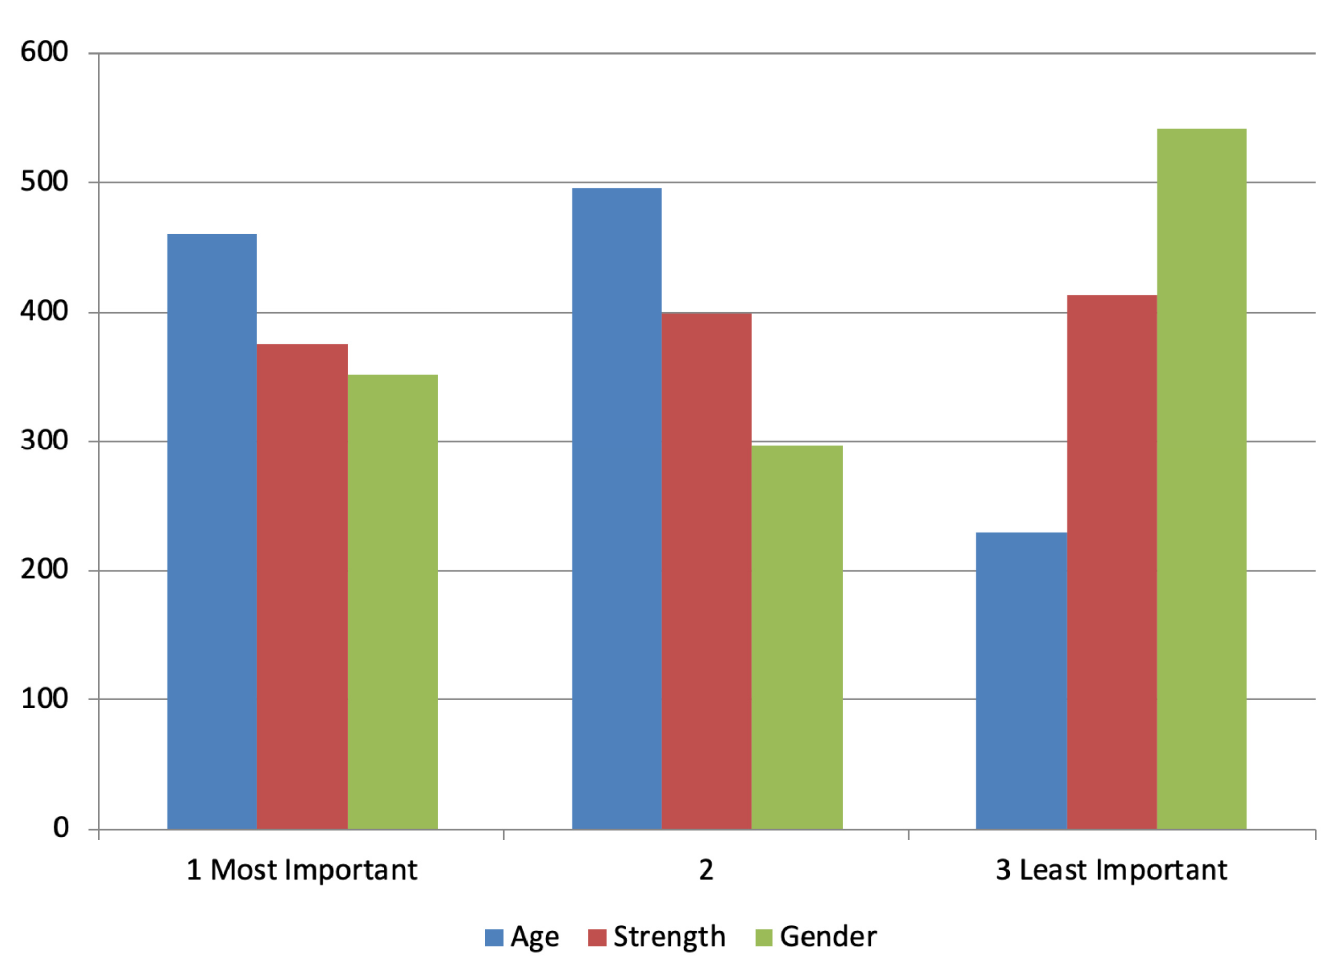
Fig 3. Allocation considerations. Fig 3: When allocating horses to riders, respondents were asked how important the riders’ age, strength and gender were in their decision-making process. 40% of respondents nominated age as the most important consideration.